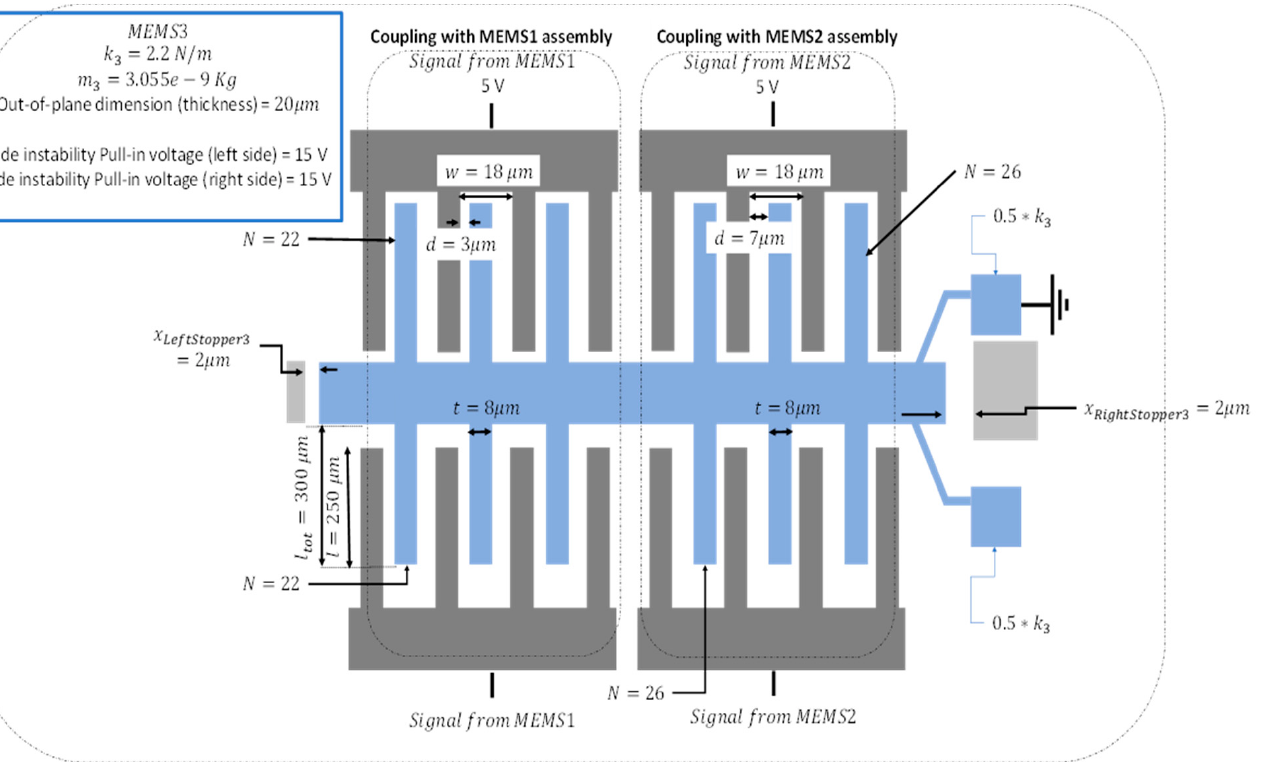
Figure A1. Design of the computing MMES device (labeled MEMS3 in Section 4), including information about the total stiffness of the MEMS device and the pull-in voltage.